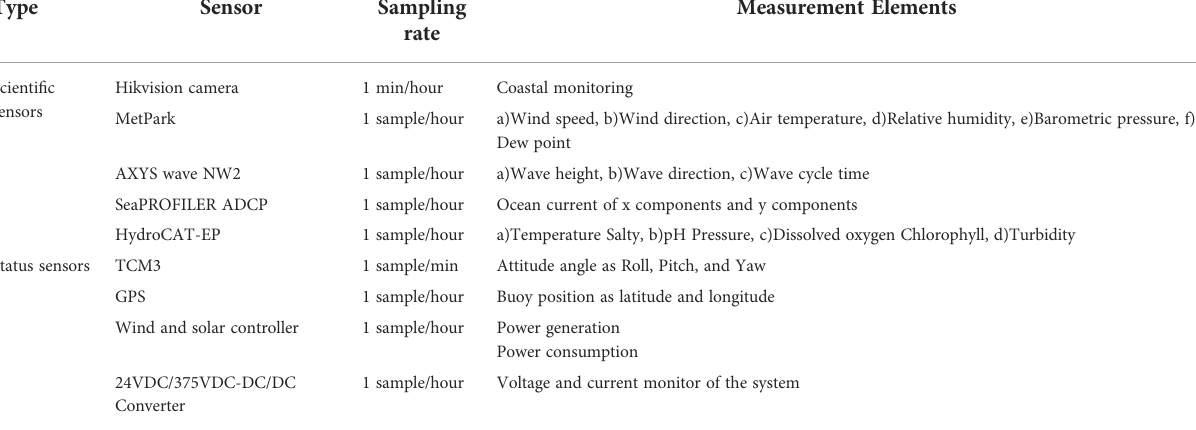
TABLE 1 Scienti fi c and status sensors on the mooring buoy.